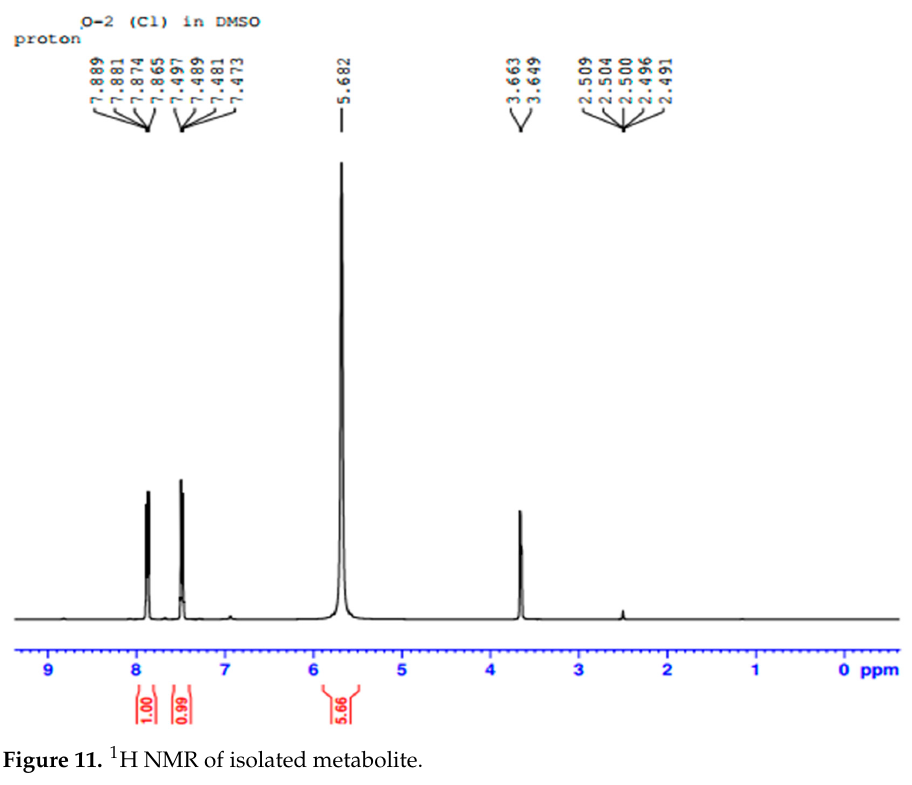
Figure 11. 1 H NMR of isolated metabolite.